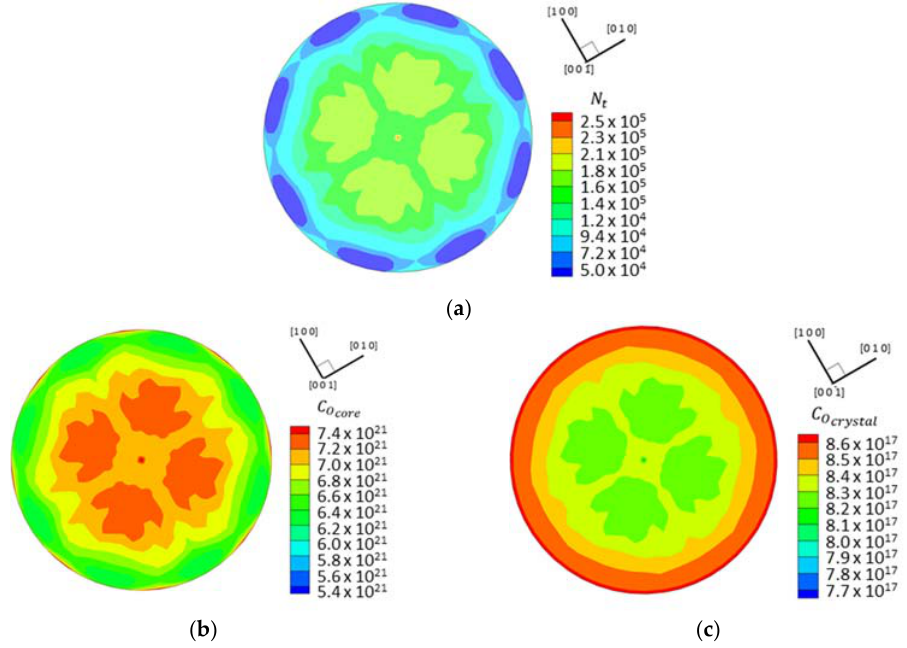
Figure 7. The distributions of the dislocation density ( a ) and oxygen concentration in the dislocation cores ( b ); and interstitial oxygen concentration in the bulk ( c ) at the bottom of the grown crystal, respectively.